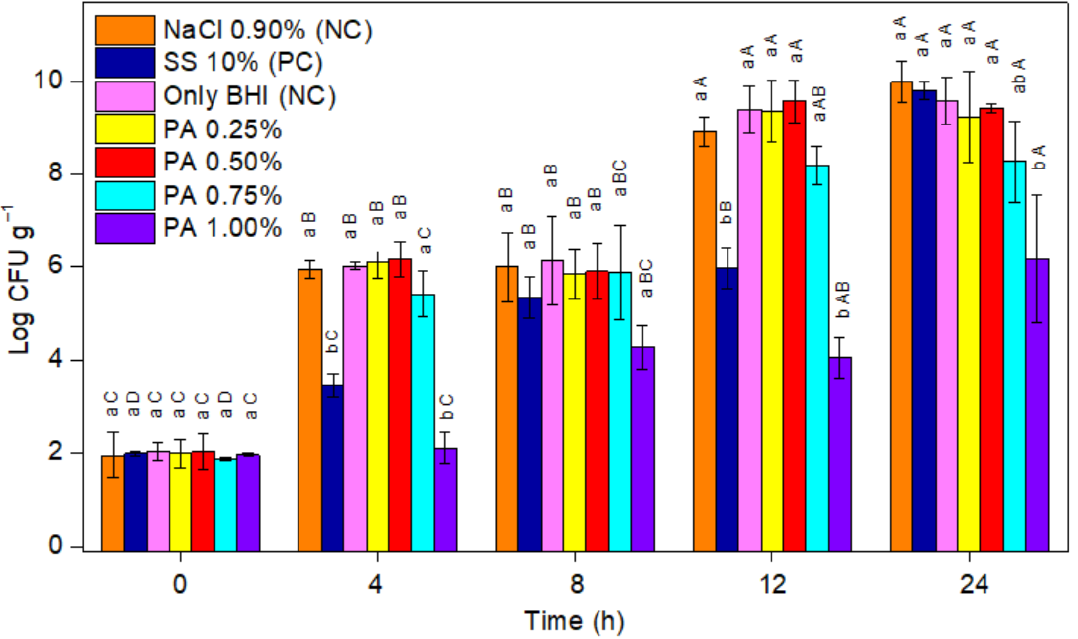
Figure 3. The effect of phytic acid (PA; 0%, 0.25%, 0.5%, 0.75%, and 1%), sodium sorbate (SS; 10%), and NaCl (0.9%) on the growth of C. perfringens vegetative cells (CFU mL − 1 ); PC: positive control; NC: negative control. The error bars represent the standard error ( n = 3); different lowercase letters indicate statistically significant differences by Tukey’s test among samples at the same time ( p < 0.05); different uppercase letters indicate statistically significant differences by Tukey’s test among the same sample at different times ( p <